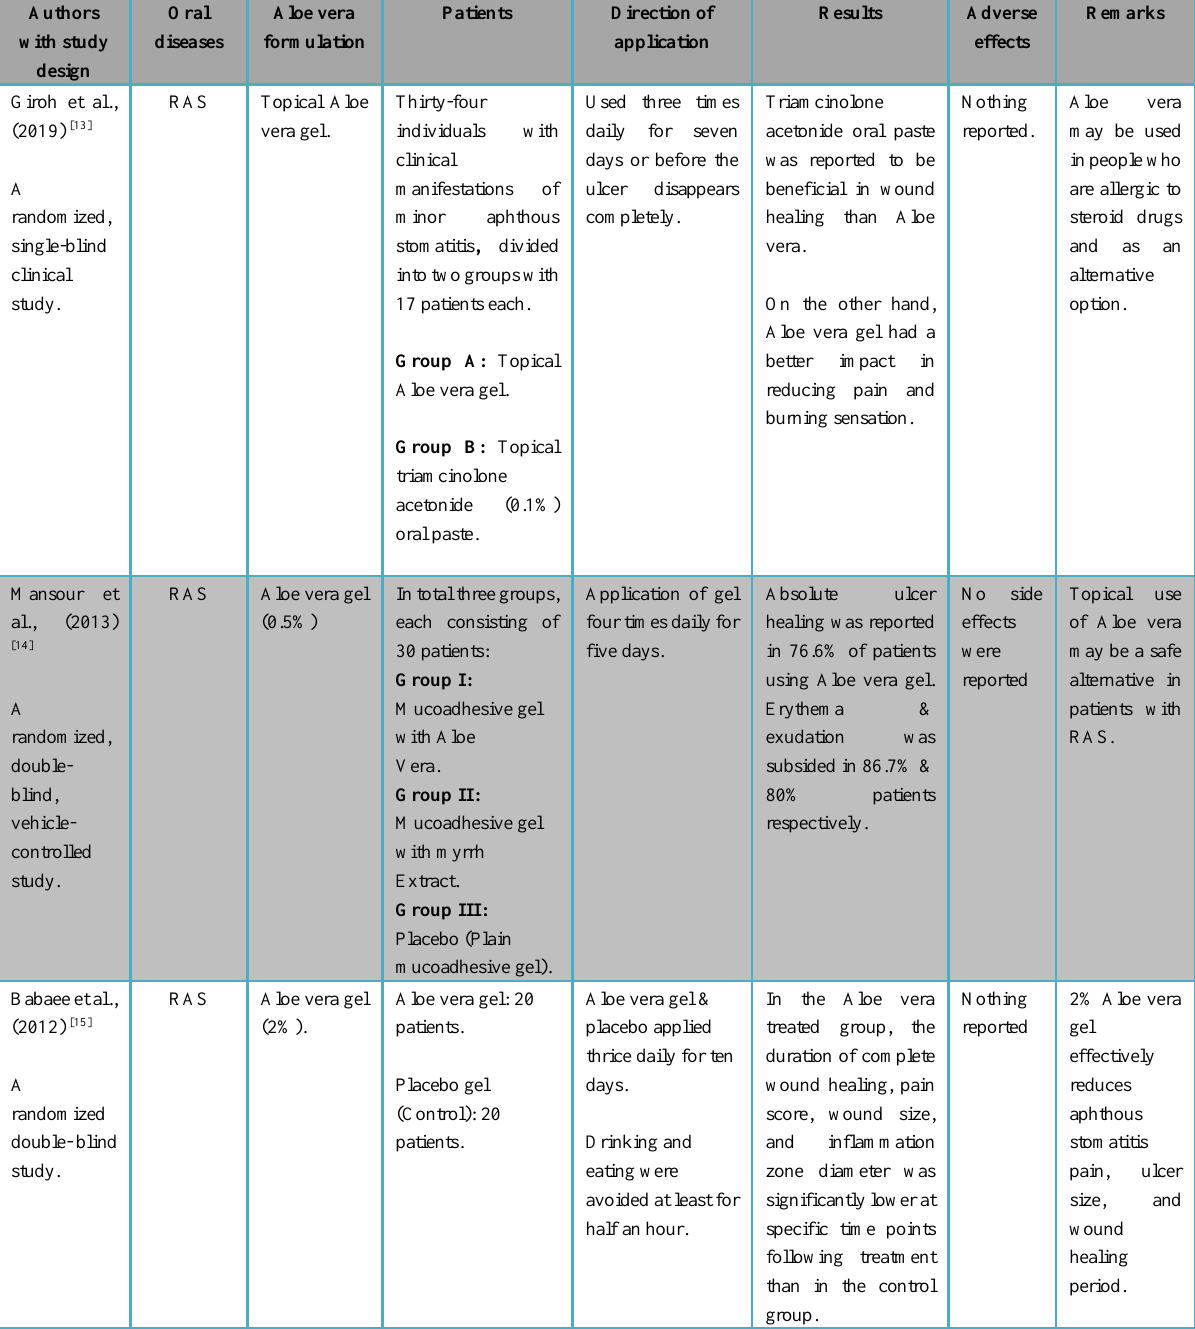
Table 1. Clinical trials of Aloe vera in treating oral mucosal